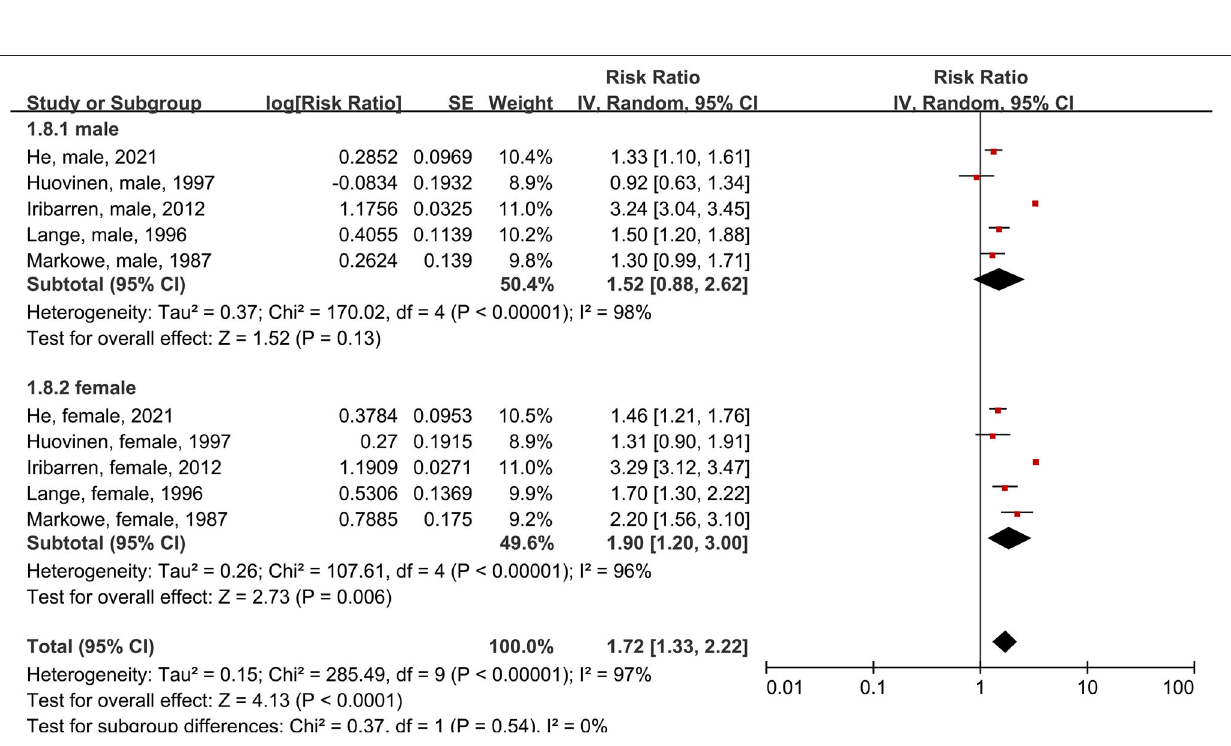
FIGURE 3 | Forest plot shows association between asthma and all-cause mortality in male and female patients. SE, standard error; IV, Inverse Variance method; df, degrees of freedom.